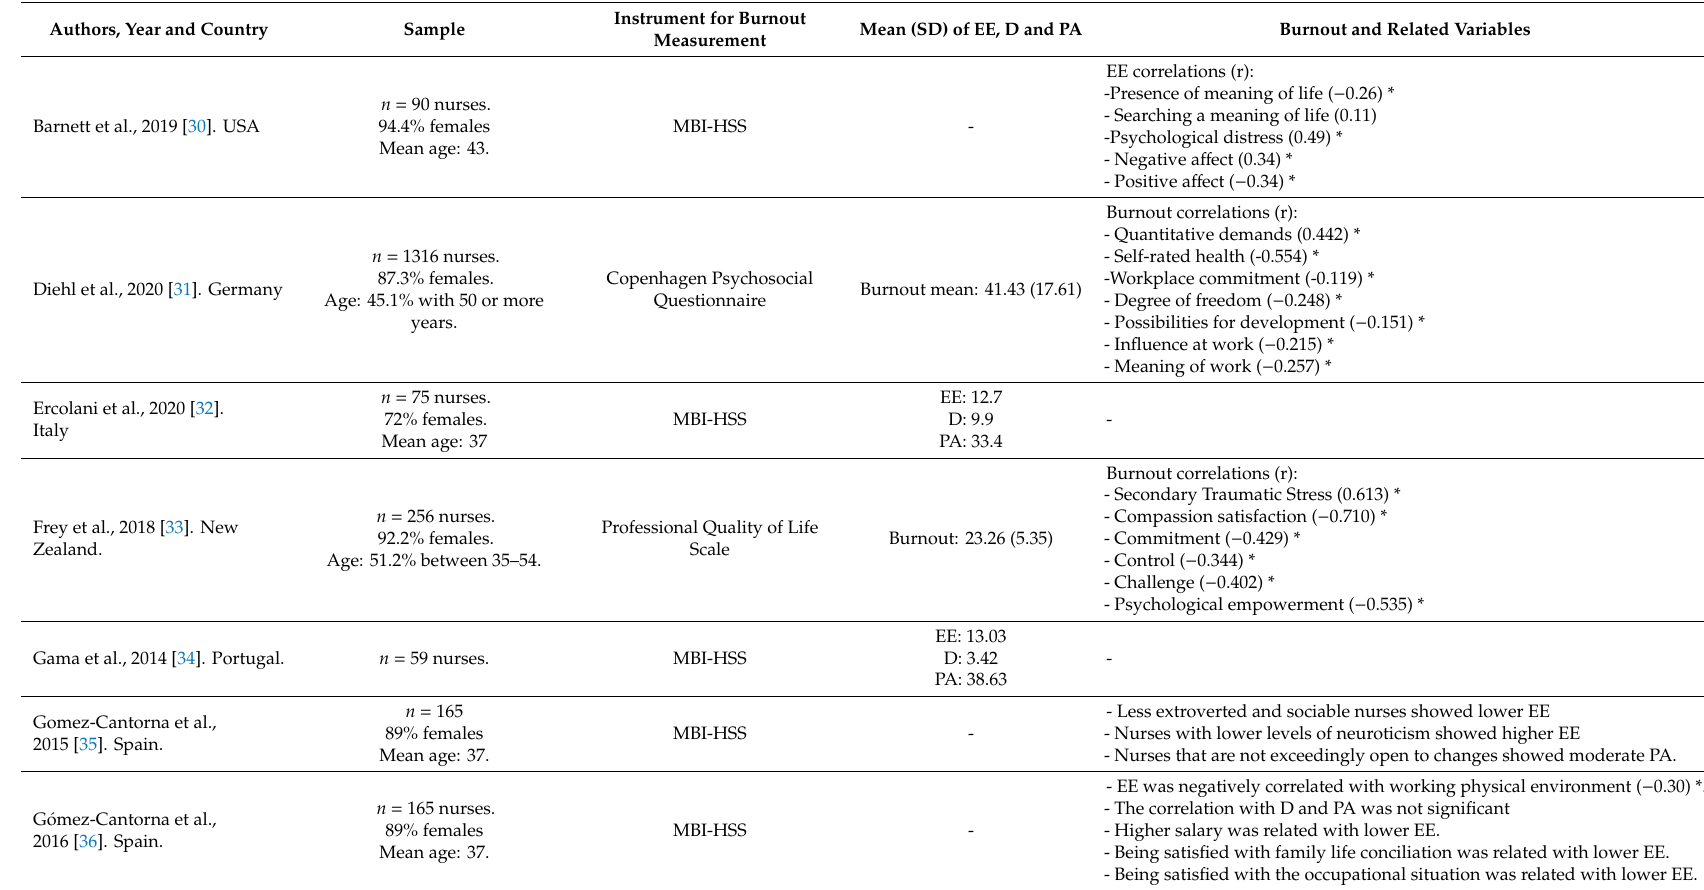
Table 1. Characteristics and main results of included studies ( n = 15).